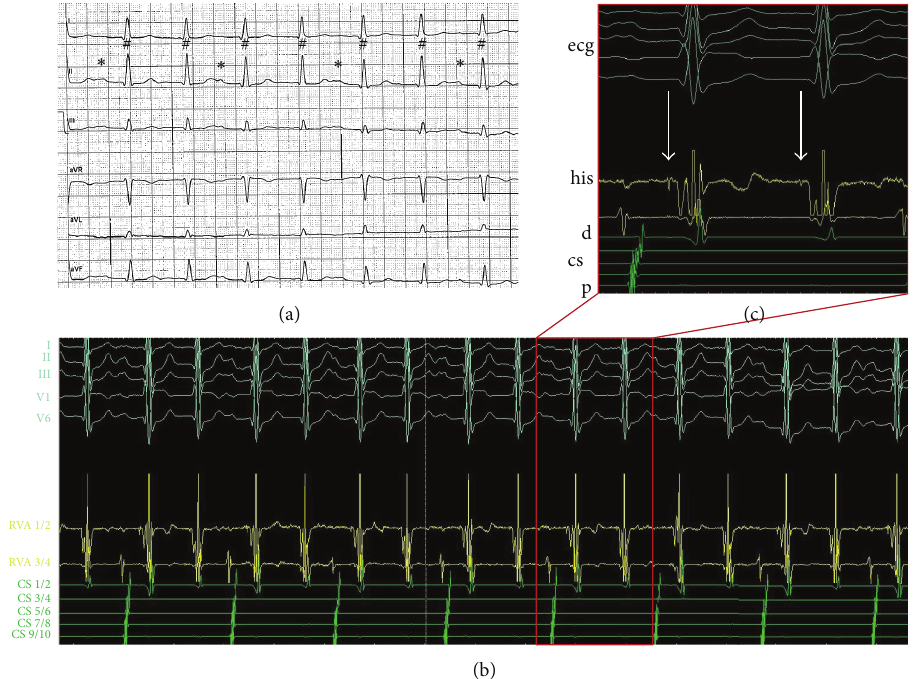
Figure 1: (a) ECG showing two ventricular beats (#) after one atrial beat ( ∗ ); (b) intracardiac electrocardiogram showing two ventricular beats after one atrial beat; (c) intracardiac electrocardiogram revealed his potential before each ventricular signal (see arrows). ECG: electrocardiography.